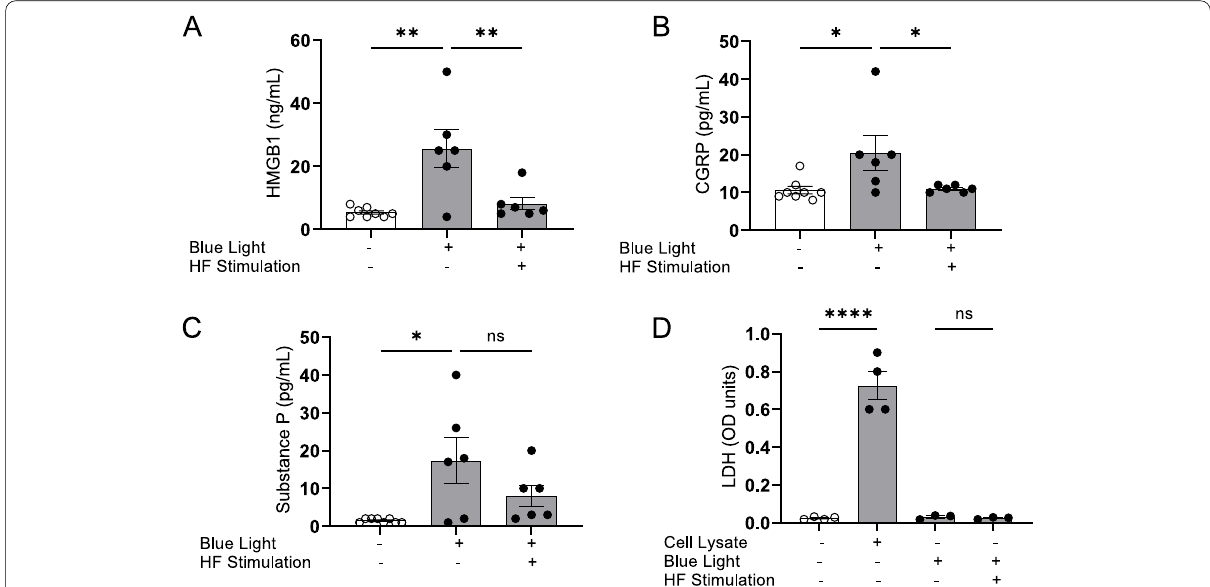
Fig. 1 HFES attenuates neuroinflammatory mediators released by optogenetic sensory neuron activation. A ‑ D Dorsal root ganglia (DRG) sensory neurons harvested from Vglut2‑Cre/ChR2‑eYFP mice were cultured on multi‑electrode arrays (MEA) culture plates for 48–72 h. Cells were simultaneously stimulated with 470 nm (Blue) LED light and HFES for 15 min. Sixty minutes post‑stimulation, cell supernatants were harvested and A HMGB1, B CGRP and C substance P measured. Data are represented as individual experimental data point with mean One‑way ANOVA followed by Tukey’s multiple comparisons test between groups. * p < 0.05., ** p < 0.01, ns: not significant. D Neither optogenetic stimulation or HFES induces neuronal cell death. Cell viability was measured by LDH release with cell lysate included as positive control. n separate experiments, and each performed in duplicate. Data are represented as individual experimental data point with mean ANOVA followed by Tukey’s multiple comparisons test between groups: **** p < 0.0001. ns: not